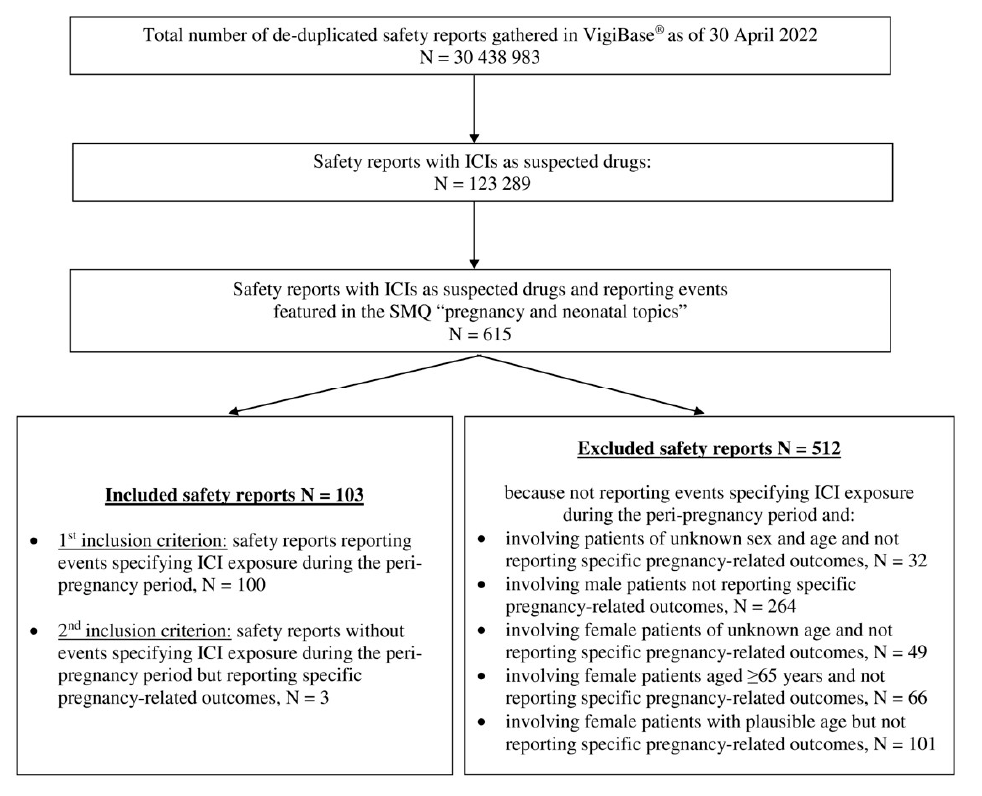
Figure 1. Flowchart. ICI, immune checkpoint inhibitor; SMQ, standardized MedDRA query.